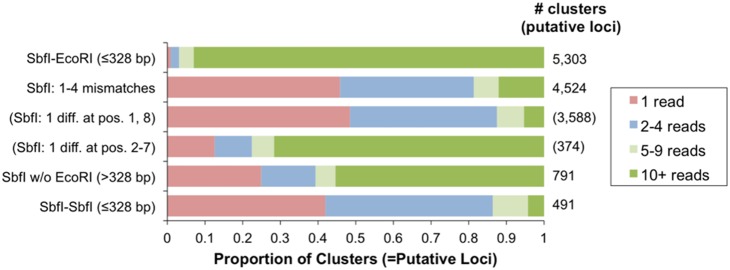
Sequencing depth for single copy ddRAD loci in relation to the corresponding sequence in the zebra finch reference genome.Categories from top to bottom include: loci mapping as expected to predicted SbfI-EcoRI restriction fragments≤328 bp in length; all loci beginning at a genomic location similar but not identical to the canonical SbfI recognition sequence (1–4 mismatches); subset of loci with one mismatch in position 1 or 8 of the SbfI recognition sequence; subset of loci with one mismatch in positions 2 through 7 of the SbfI recognition sequence; loci mapping to a genomic SbfI site without an EcoRI site within 328 bp; and loci mapping to a predicted SbfI-SbfI restriction fragment less than 328 bp in length.